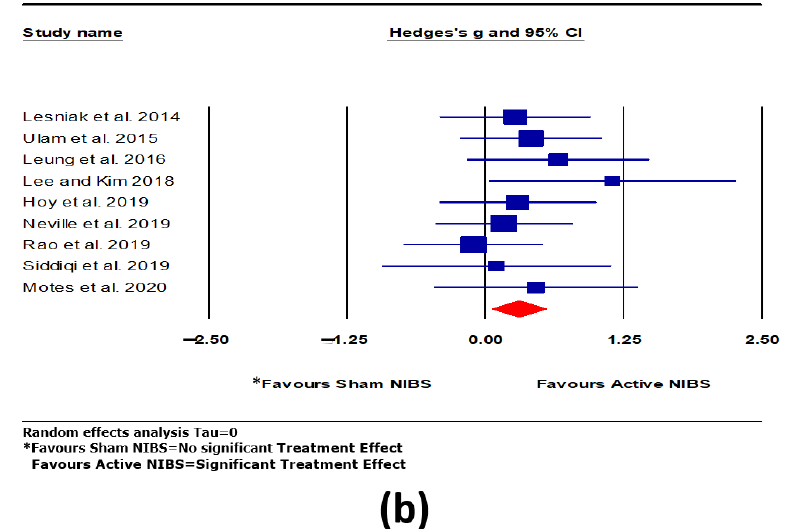
Figure 2. The effect of non-invasive brain stimulation (NIBS) on overall cognitive outcomes; ( a ) sum-